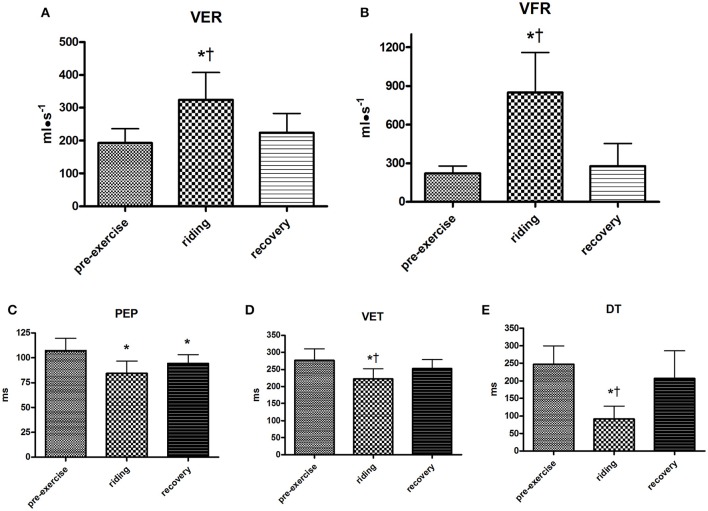
Group ventricular emptying rate (VER, A), ventricular filling rate (VFR, B), pre-ejection period (PEP, C), ventricular ejection time (VET, D), and diastolic time (DT, E) during the various periods of the Enduro session. Values are mean ± SD (n = 15). *p < 0.05 vs. pre-exercise; †p < 0.05 vs. recovery.